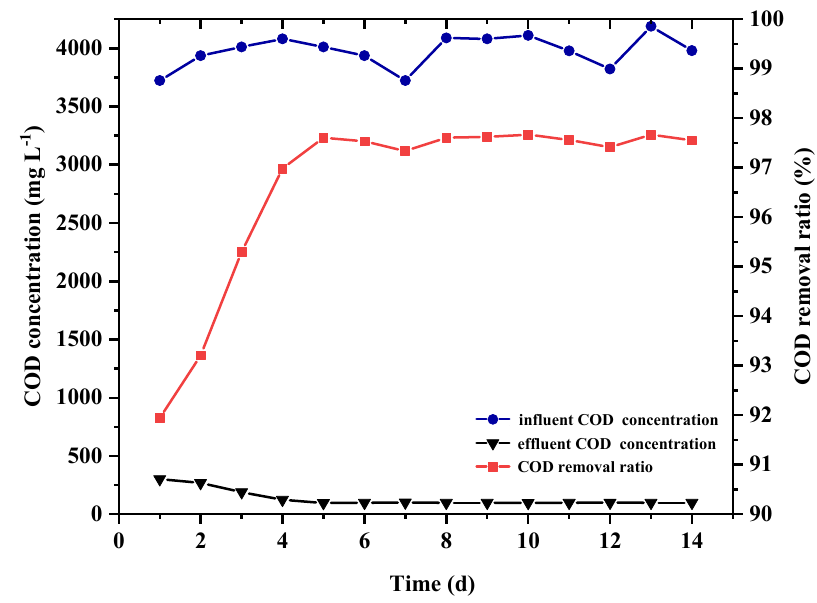
Figure 3. The change of COD removal ratio.